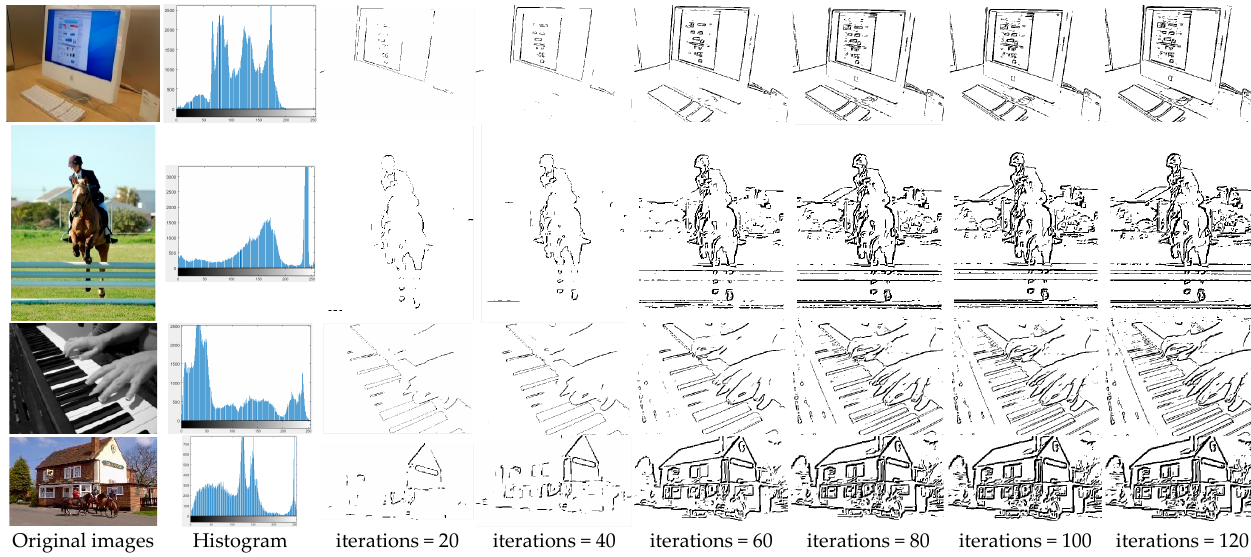
Figure 3. The test results of the proposed algorithm on the Pascal VOC dataset.